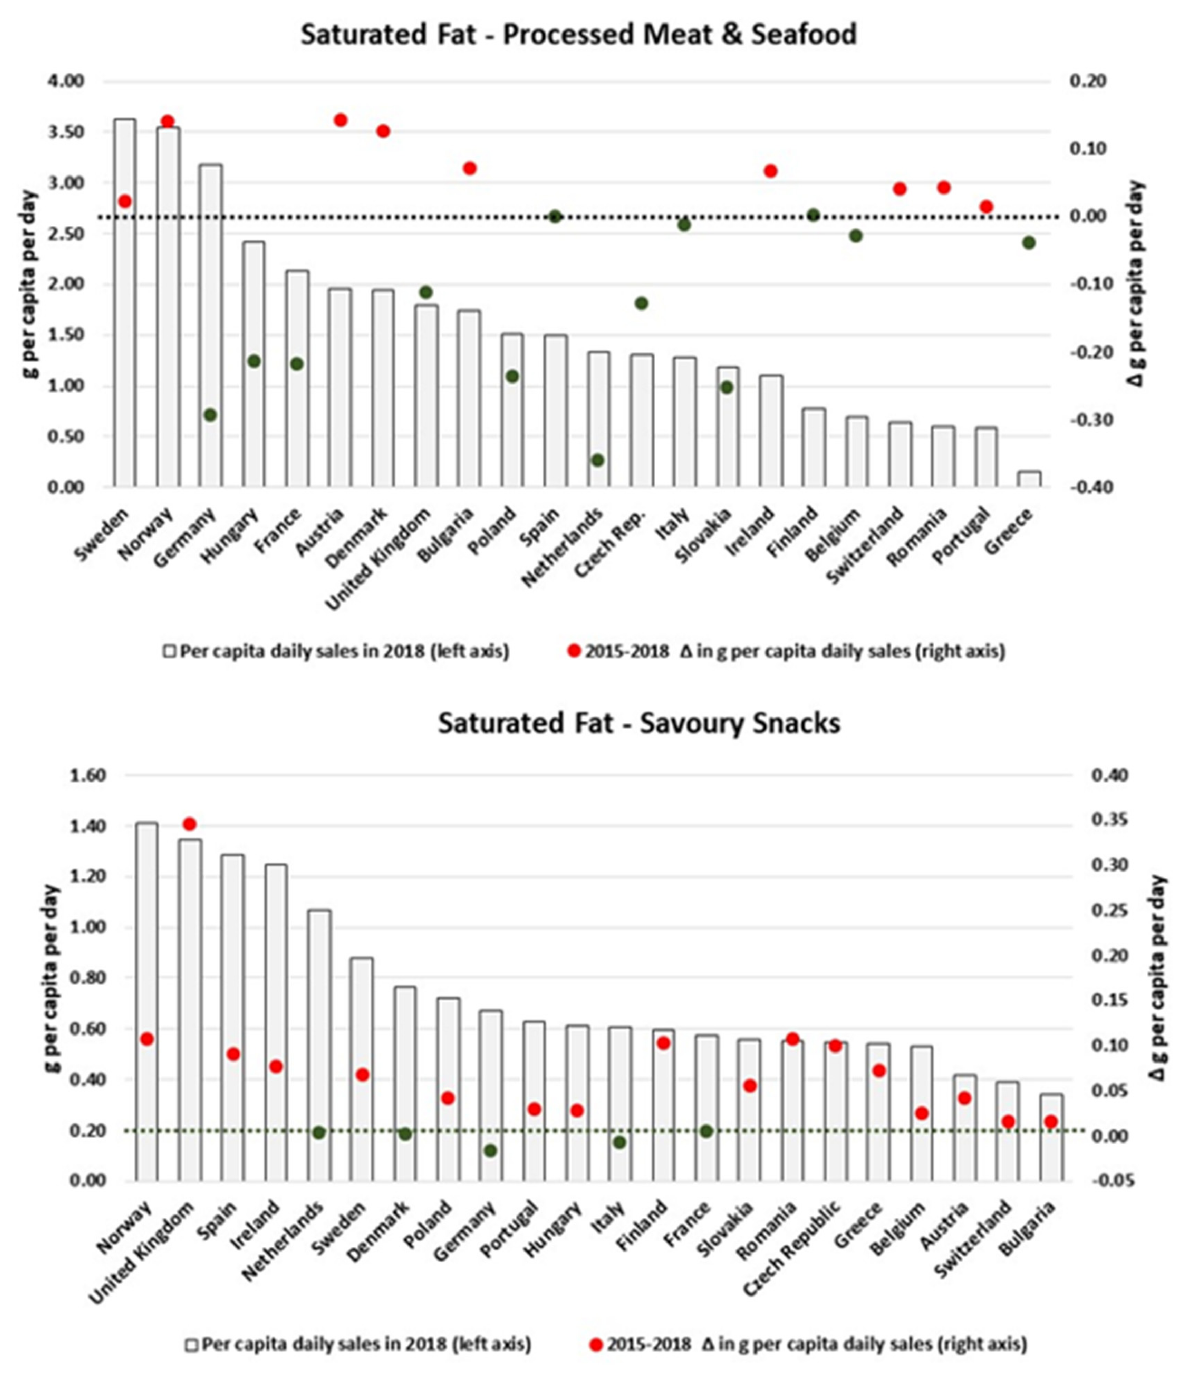
Figure 5. Estimates of saturated fat sold through Processed M & S and Savoury Snacks in 2018 and the respective 2015–2018 variation (in g/pc/day). Source: Elaborated by the authors based on data from Euromonitor (2020) and mid-year population estimates from the HFA-DB. Estimates were scaled by market coverage to represent 100% of the retail market. The right-hand axis represents the nutrient variation in g per capita per day (green for negative values, red for positive values), and the dotted black line indicates the variation of 0 g per capita per day as a reference.